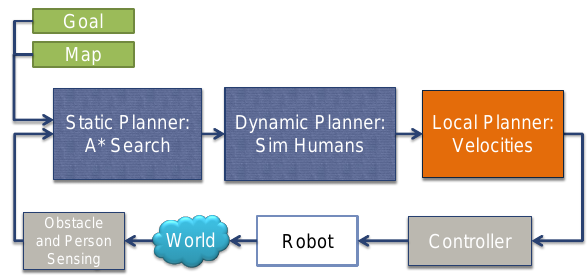
Figure 12: System overview. When a map and goal is provided to the static planner obstacles and humans are detected and then a path is planned using A* search. The dynamic planner refines the static plan by simulating human reactions to the robot motion. The local planner receives the result, and computes the linear and angular velocities necessary to follow the path. The controller applies these velocities to the robot, which in turn acts in the world. The sensors generate new data, and the loop